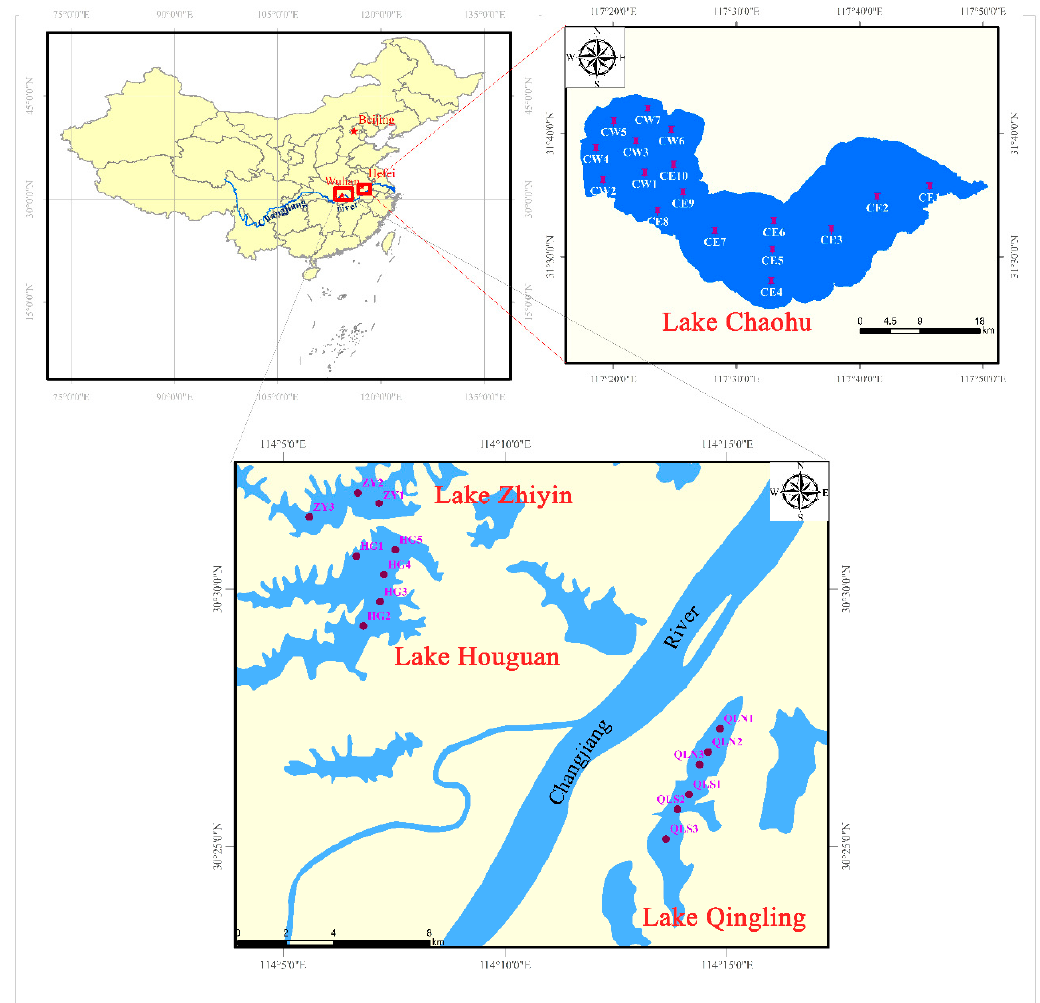
Figure 1. Map of studied lakes (Lake Chaohu (two basins: CHE and CHW), Lake Zhiyin (ZY), Lake Houguan (HG), and Lake Qingling (two basins: QLS and QLN)) showing the sampling sites. Lake Qingling (30°25 ′ –30°27 ′ N, 114°13 ′ –114°14 ′ E) is about 9.6 km 2 . The average depth is 1.7 m.